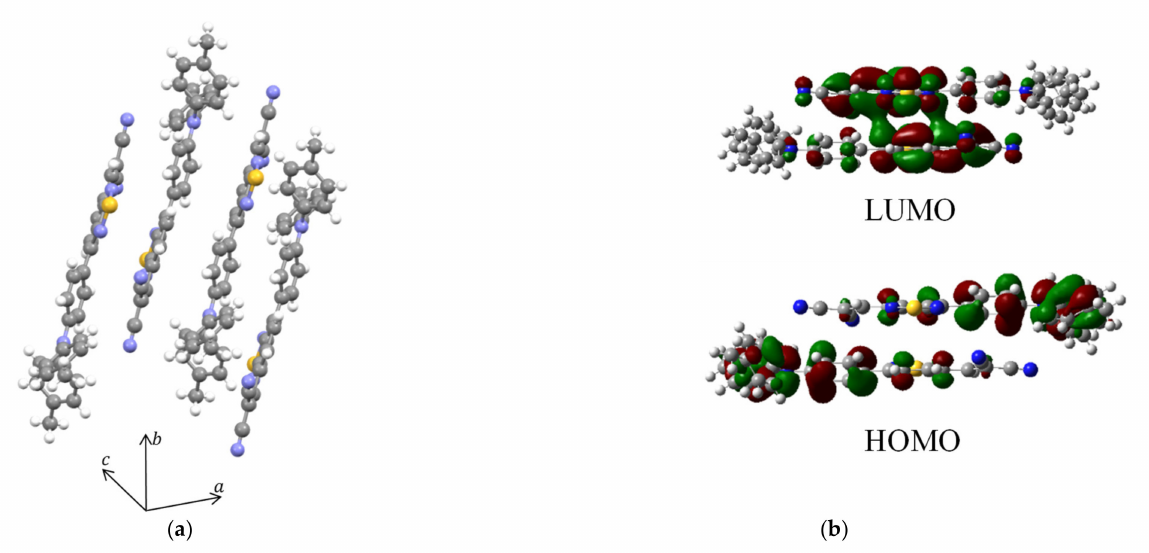
Figure 7. ( a ) Single crystal structure of DTDCPB. ( b ) Distribution of HOMO and LUMO for the DTDCPB